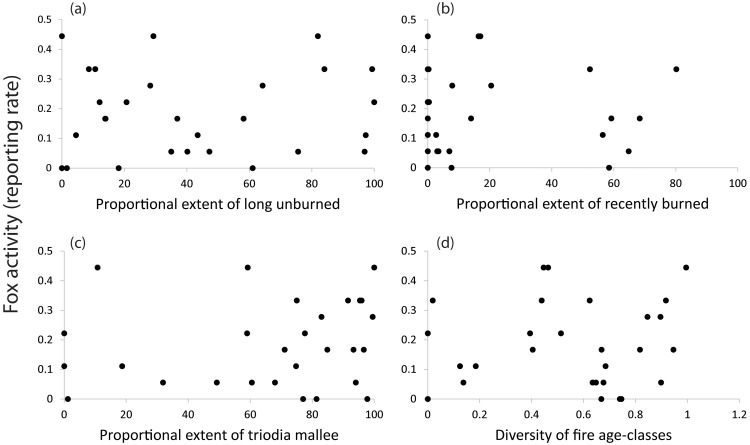
Relationships between the reporting rate of the red fox and the properties of fire mosaics.Circles are raw data points.